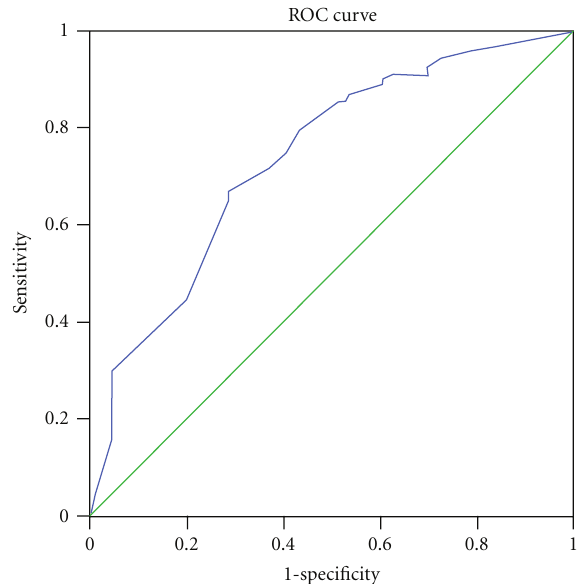
Figure 2: ROC curve for number of natural teeth discriminating those with/without oral impacts in ≥ 60 year olds. AUC = 0.737 (95% CI = 0.684–0.790); P < 0 . 001. Optimal cuto ff based on curve = 18/19